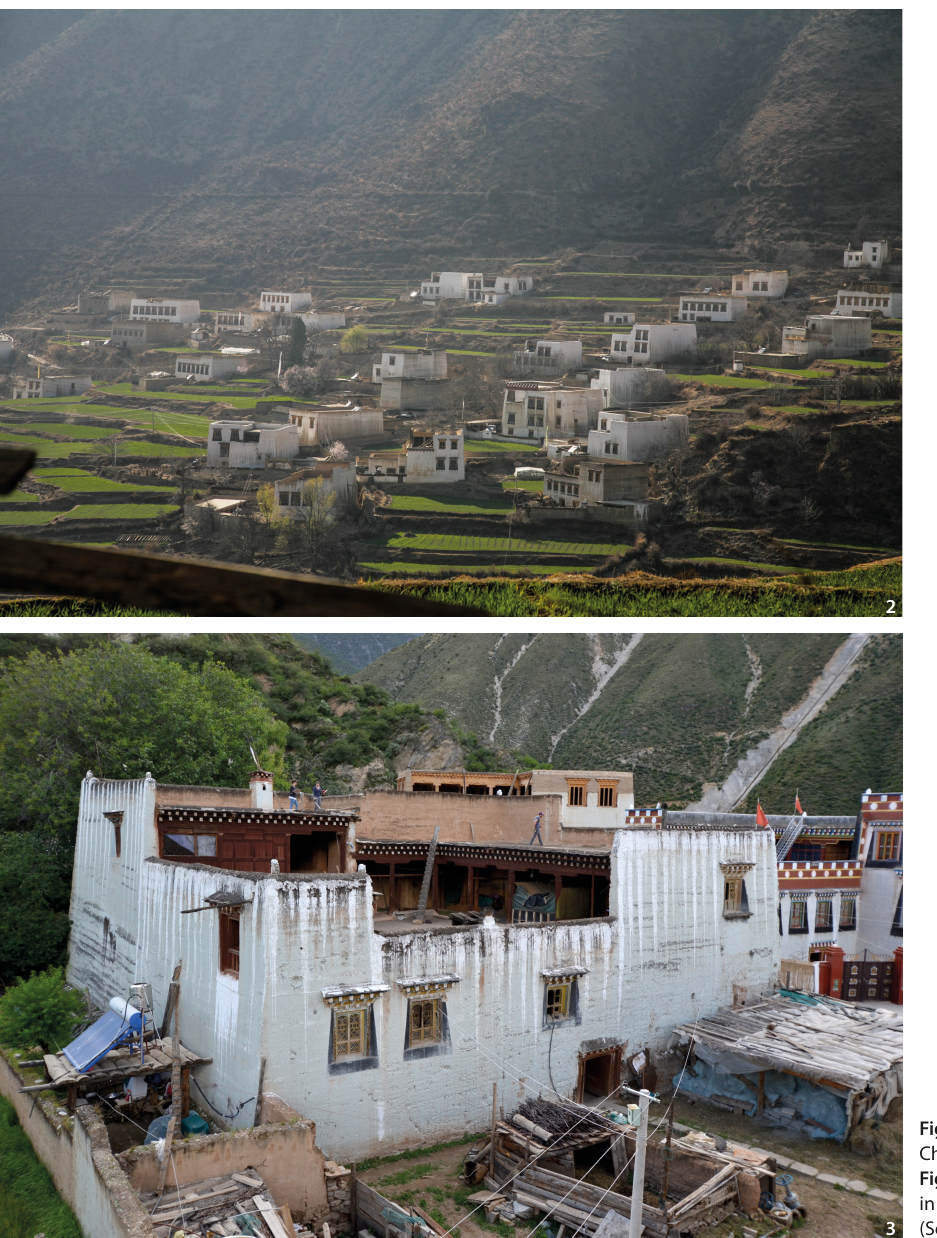
Figure 2 Village in the region of Chatreng (Source: the authors). Figure 3 View of the farmhouse in Chatreng from the southeast (Source: the